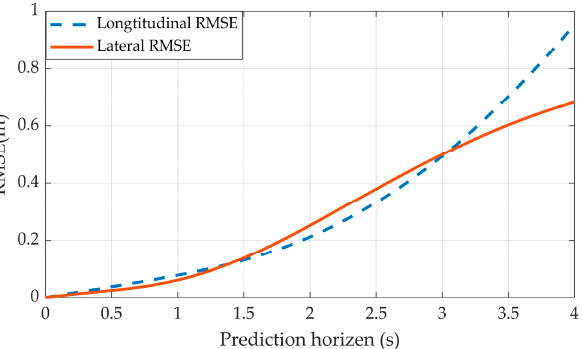
Figure 7. The RMSE in lateral and longitudinal directions. When predicted horizon = 4 s, the prediction reaches max error with 0.68 m (lateral) and 0.95 m (longitudinal).